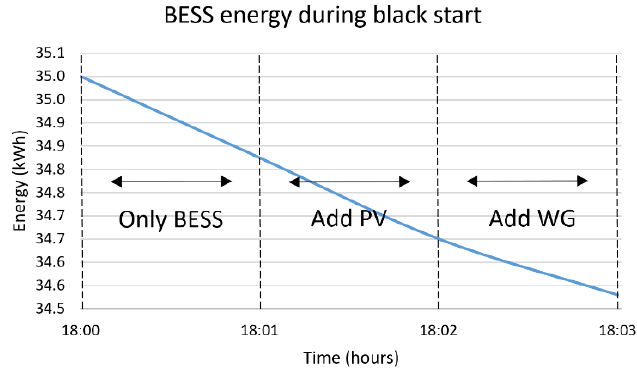
12 of 17 Figure 9 . Energy dispatch for islanded operation from 13:00 to 19:00. 4.3. Results of Case 3 The blackout is considered to happen at 18:00, which is the worst possible scenario due to the maximized difference between the load and RES production, equal to 6.3 kW, followed by a three-hour islanded operation mode. The solution to this problem requires two timescales, a short one for the black start with time-steps set equal to one minute and a long one for the islanded mode with time-steps set equal to one hour. The results are presented in Figure 10, Figure 11, Figure 12 and Figure 13 . During the first step of the black start, the two BESS are activated, since they constitute the only controllable supply units. Their activation is followed by the PVs in the second step, the production of which